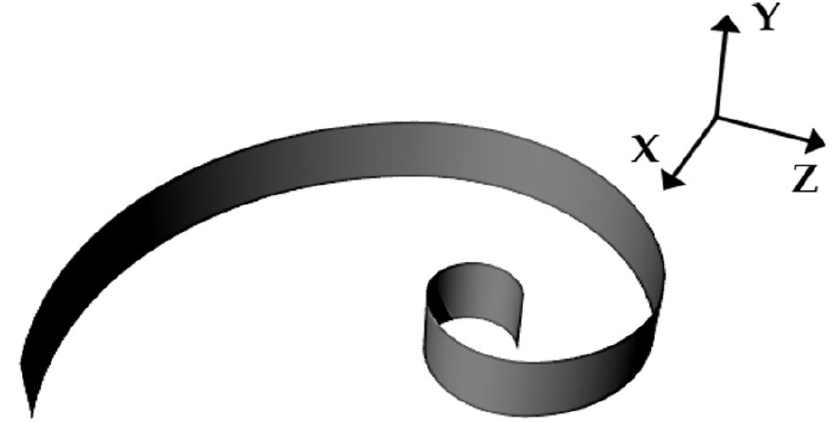
Figure 2. Spatial arrangement of the PVDF sensor.